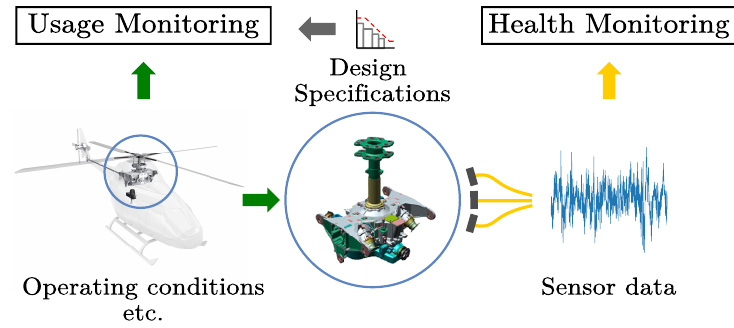
Figure 1. Overview of the health and usage monitoring of a helicopter